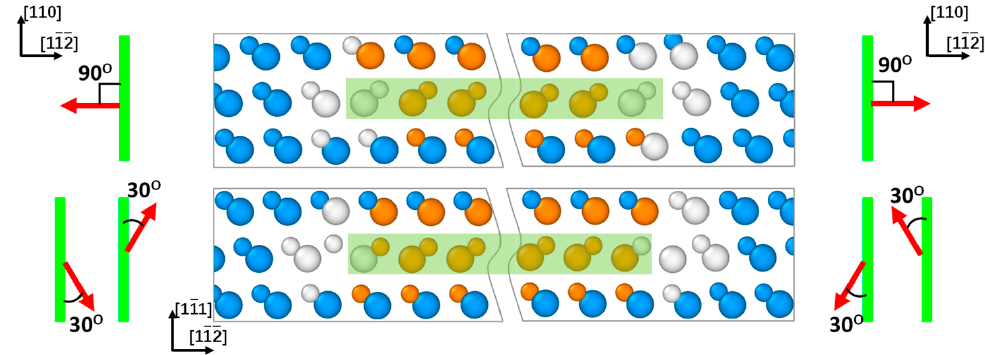
Figure 1. Atomic configurations of the dislocation dipoles consisting of Si- and C-terminated 90 ◦ (top panel) and C- and Si-terminated 30 ◦ (bottom panel) Shockley partial dislocations viewed in the direction [110]. Left and right panels show schematic representations of the dislocation Burgers vectors with respect to the dislocation lines viewed perpendicular to the [ 111 ] plane. Highlighted are the stacking faults formed between the partial dislocations in the dipoles. Vertical lines in the left and right panels correspond to the dislocation lines, and the arrows indicate possible directions of the dislocation Burgers vectors, respectively.